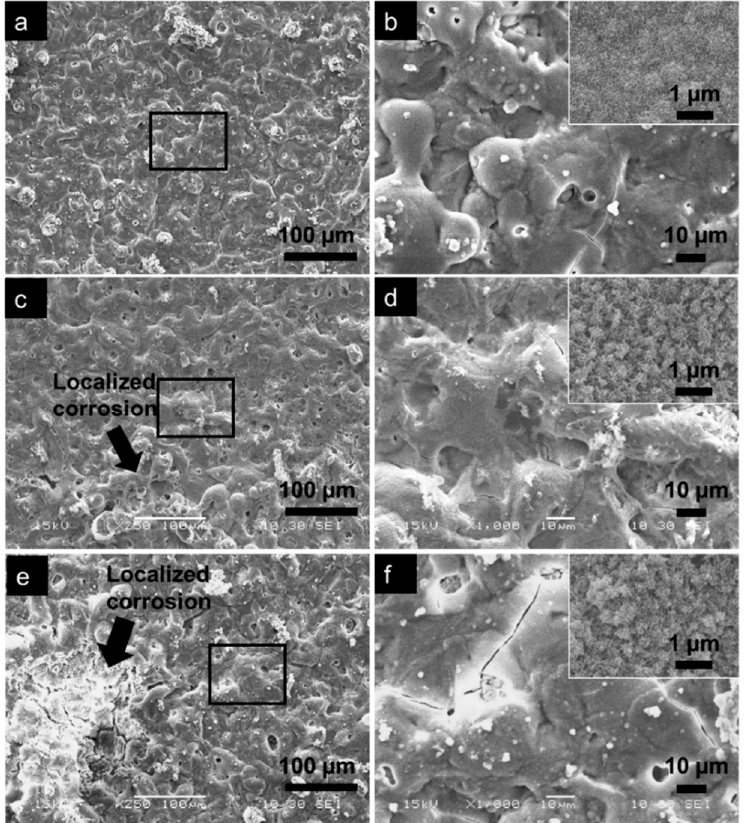
Figure 10. SEM images of PEO coatings on ( a ) and ( b ) AZ61, ( c ) and ( d ) AZX611, and ( e ) and ( f ) AZX612 specimens after 14 days of immersion in SBF showing the corrosion morphology. (b), (d), (f) are higher magnification images of the area inside the rectangle in images (a), (c), (e), respectively. The inset image shows the apatite layer structure.